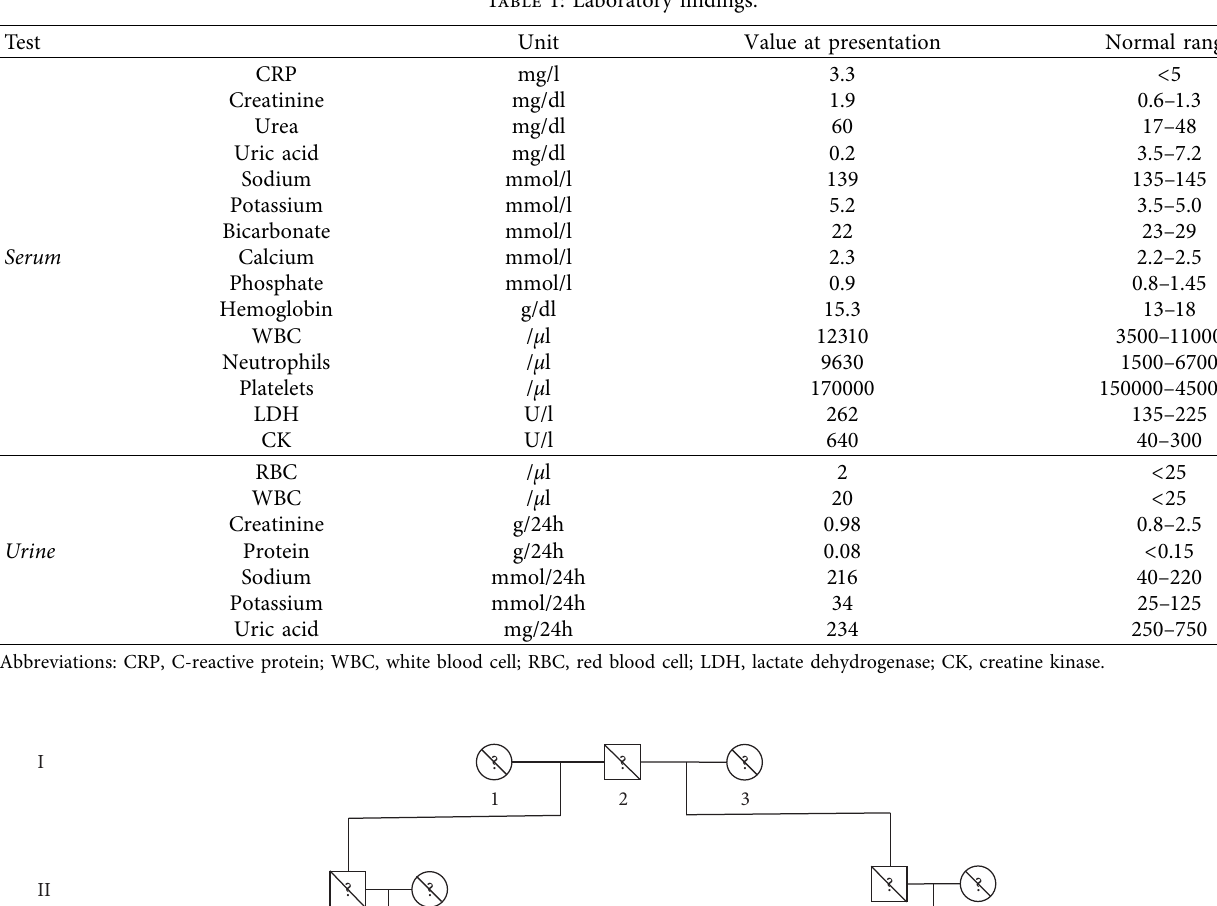
Table 1: Laboratory findings.